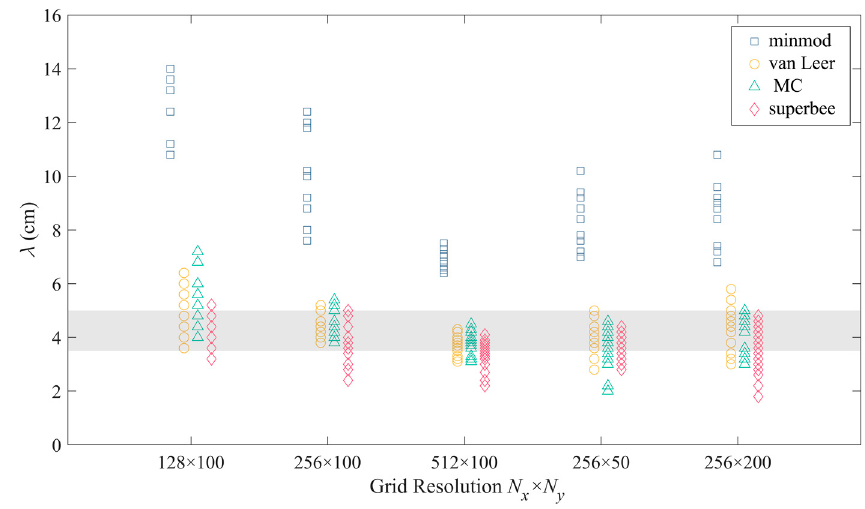
Figure 8. The wavelengths λ of the unstable wave obtained by simulation results. The shade zone represents the range of the wavelength data from the laboratory observation [37].